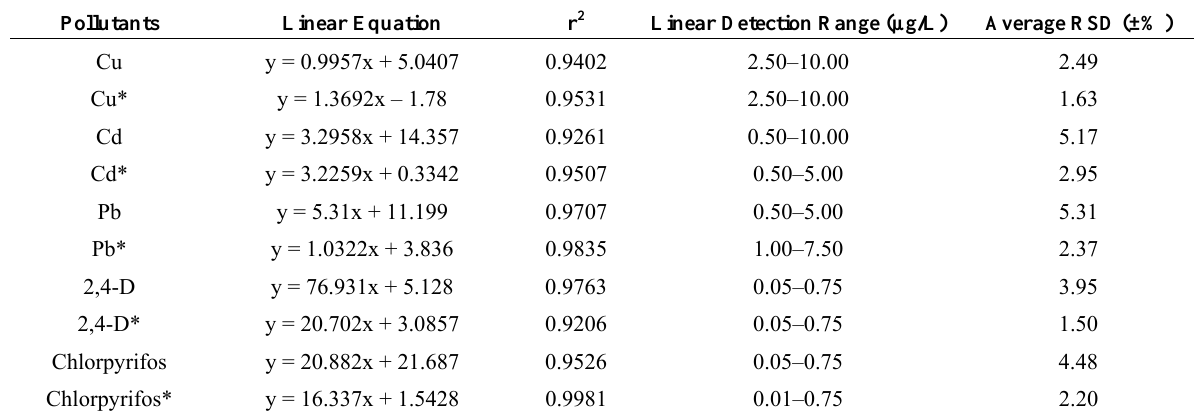
Table 1. The linear equations, the value of r 2 , linear detection ranges, and average RSD of Cu, Cd, Pb, 2,4-D and Chlorpyriphos biosensors, with asterisk * marks the tests conducted with